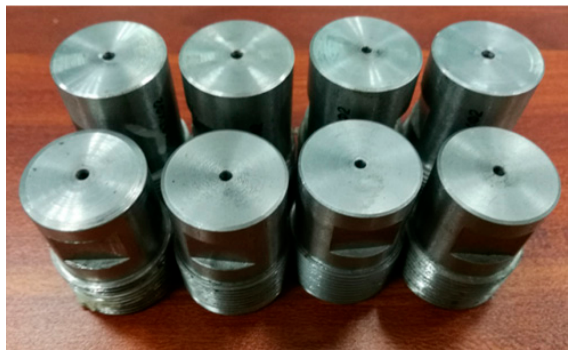
Figure 3. The picture of the organ-pipe nozzles.